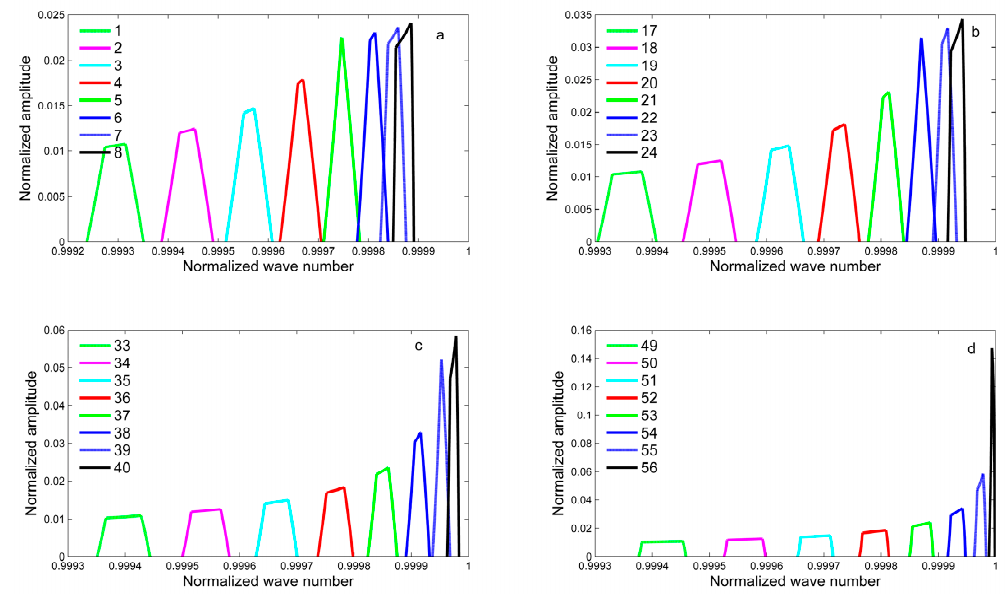
Figure 9. The instrumental line shape (ILS) of typical detectors in the focal plane of